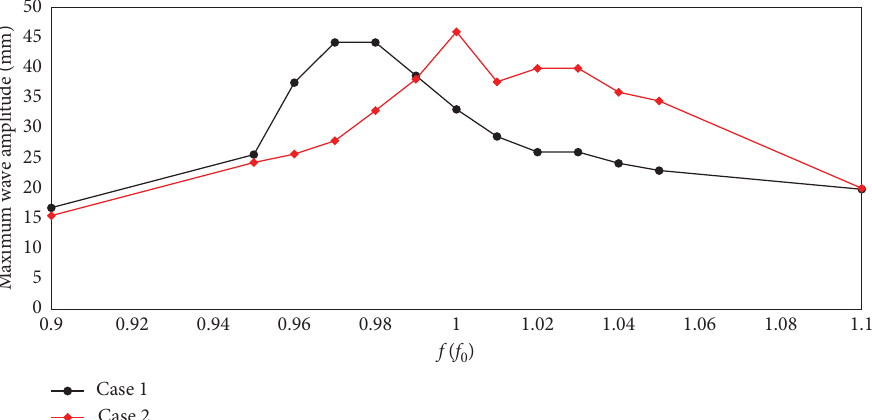
Figure 6: Comparisons of maximum wave amplitude of sloshing in the tank with vertical baffle and with T-type baffle under coupled excitation of surge and pitch.